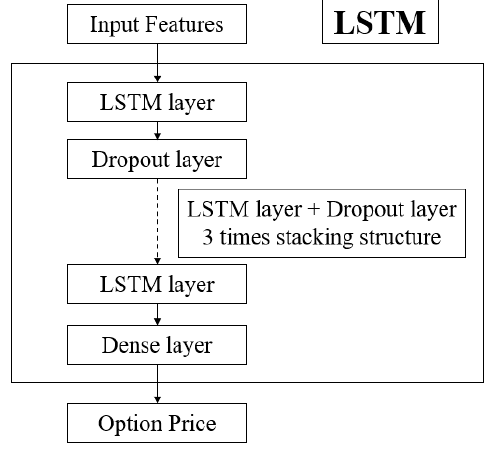
Figure 4. The layers of LSTM model.